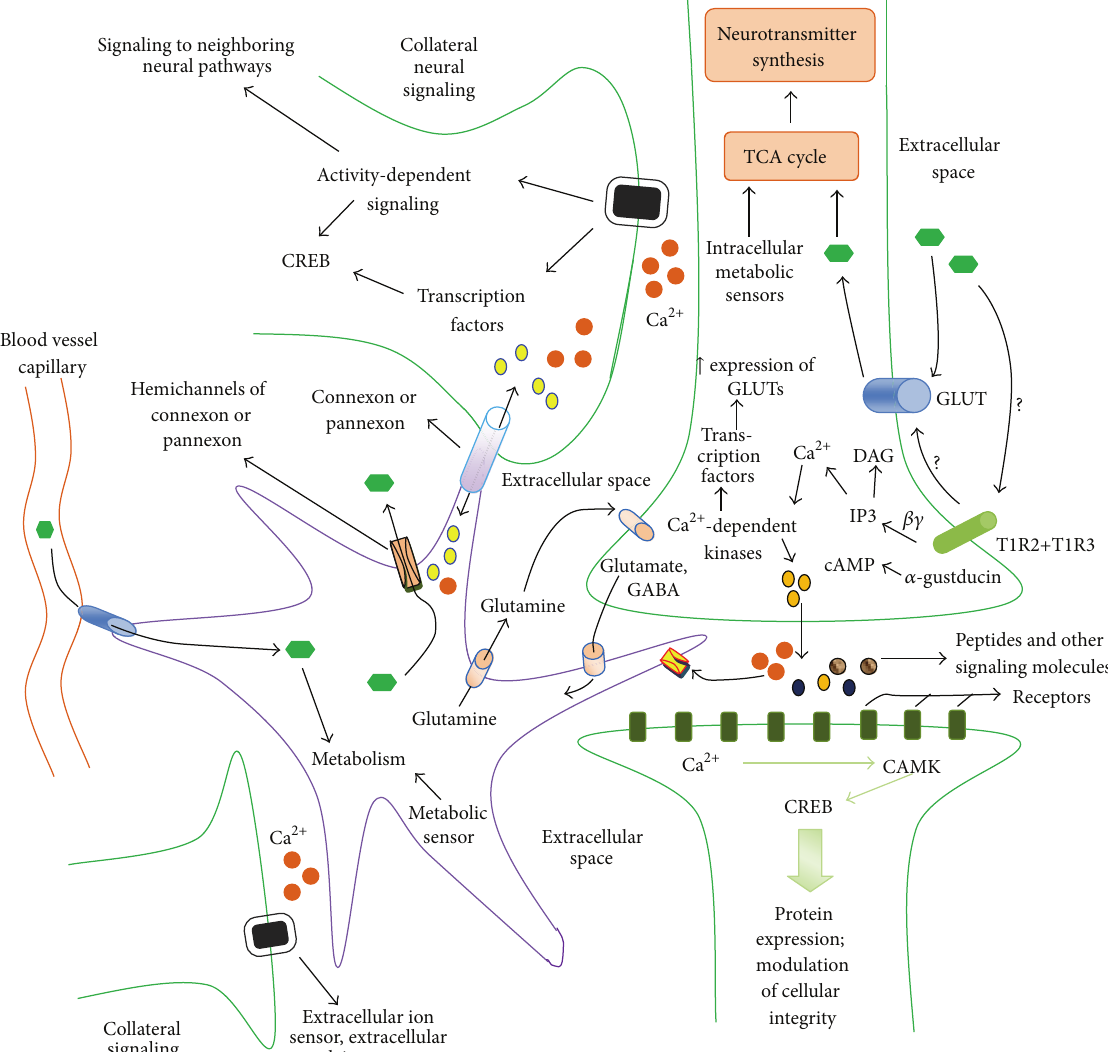
Figure 2: Sweet taste signaling network of the neuroastroglial system. The brain is a complex network of cells, largely populated by neurons and astrocytes. There are ∼ 100 billion neurons, with glial cells outnumbering neurons by about 10-fold. Astrocytes form the largest population of glial cells. The metabolic role of astrocytes in brain has been reviewed in our previous work [60]. Mechanisms of how glucose enters